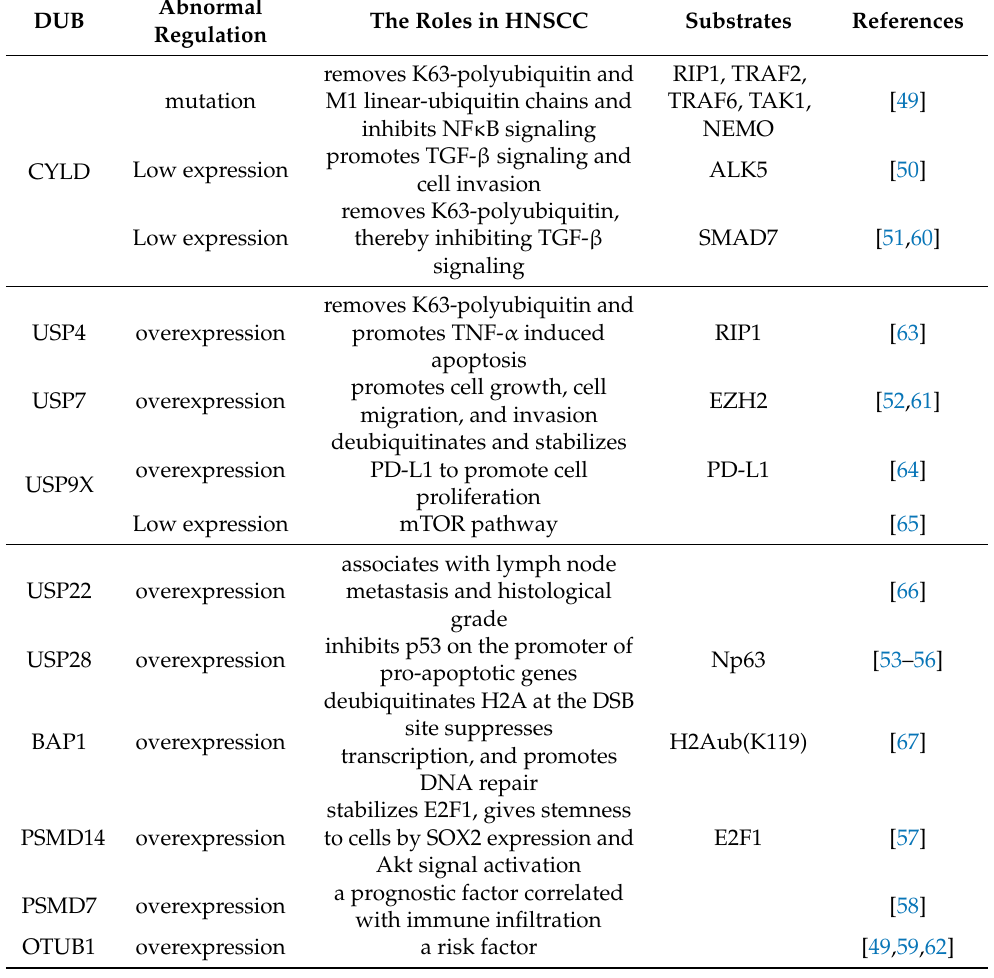
Table 2. DUB function in